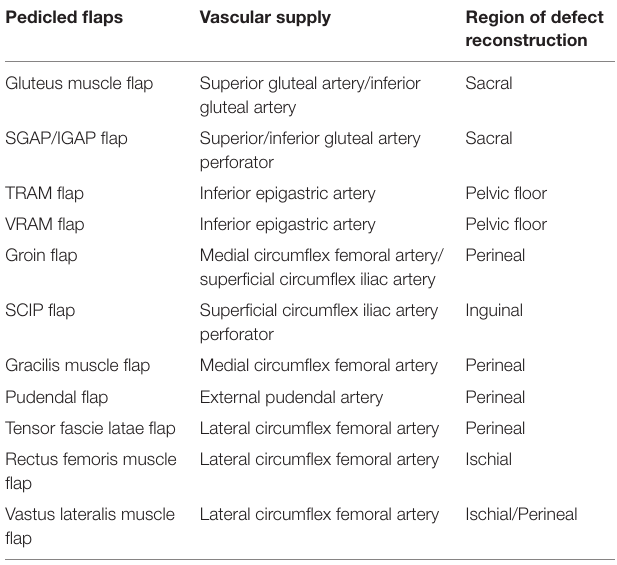
TABLe 1 | The most useful pedicled flaps for defect reconstruction of the pelvic region [modification of Beier et al. (3) and Das Gupta et al.